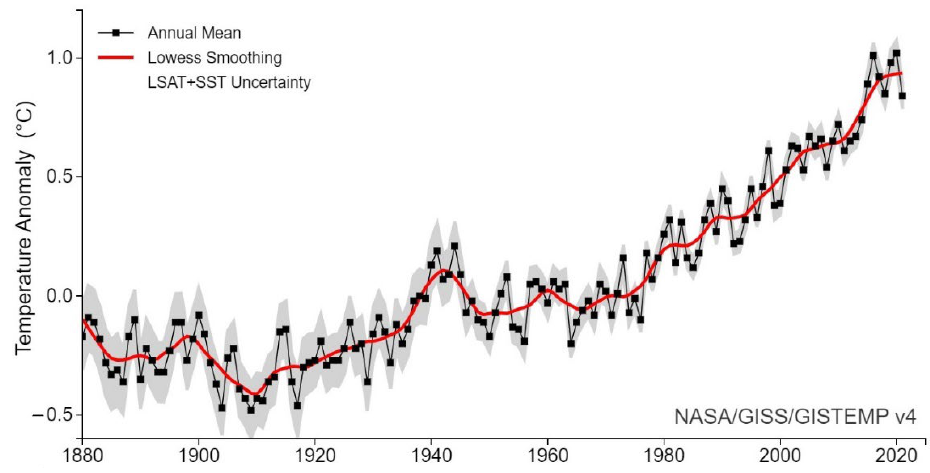
Figure 1. Global mean estimates in the years 1880–2020 on land and ocean data with base period 1951–1980. Source: [4].